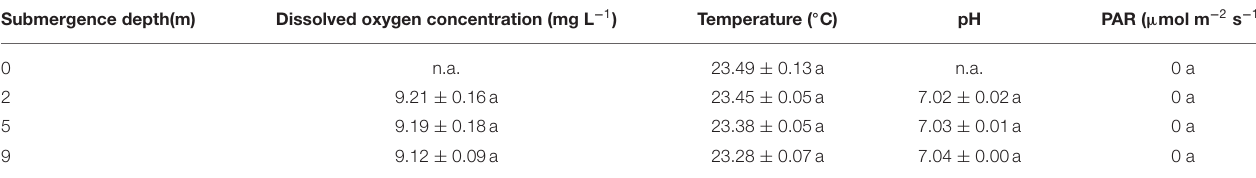
TABLE 1 | Physico-chemical properties of water in submergence